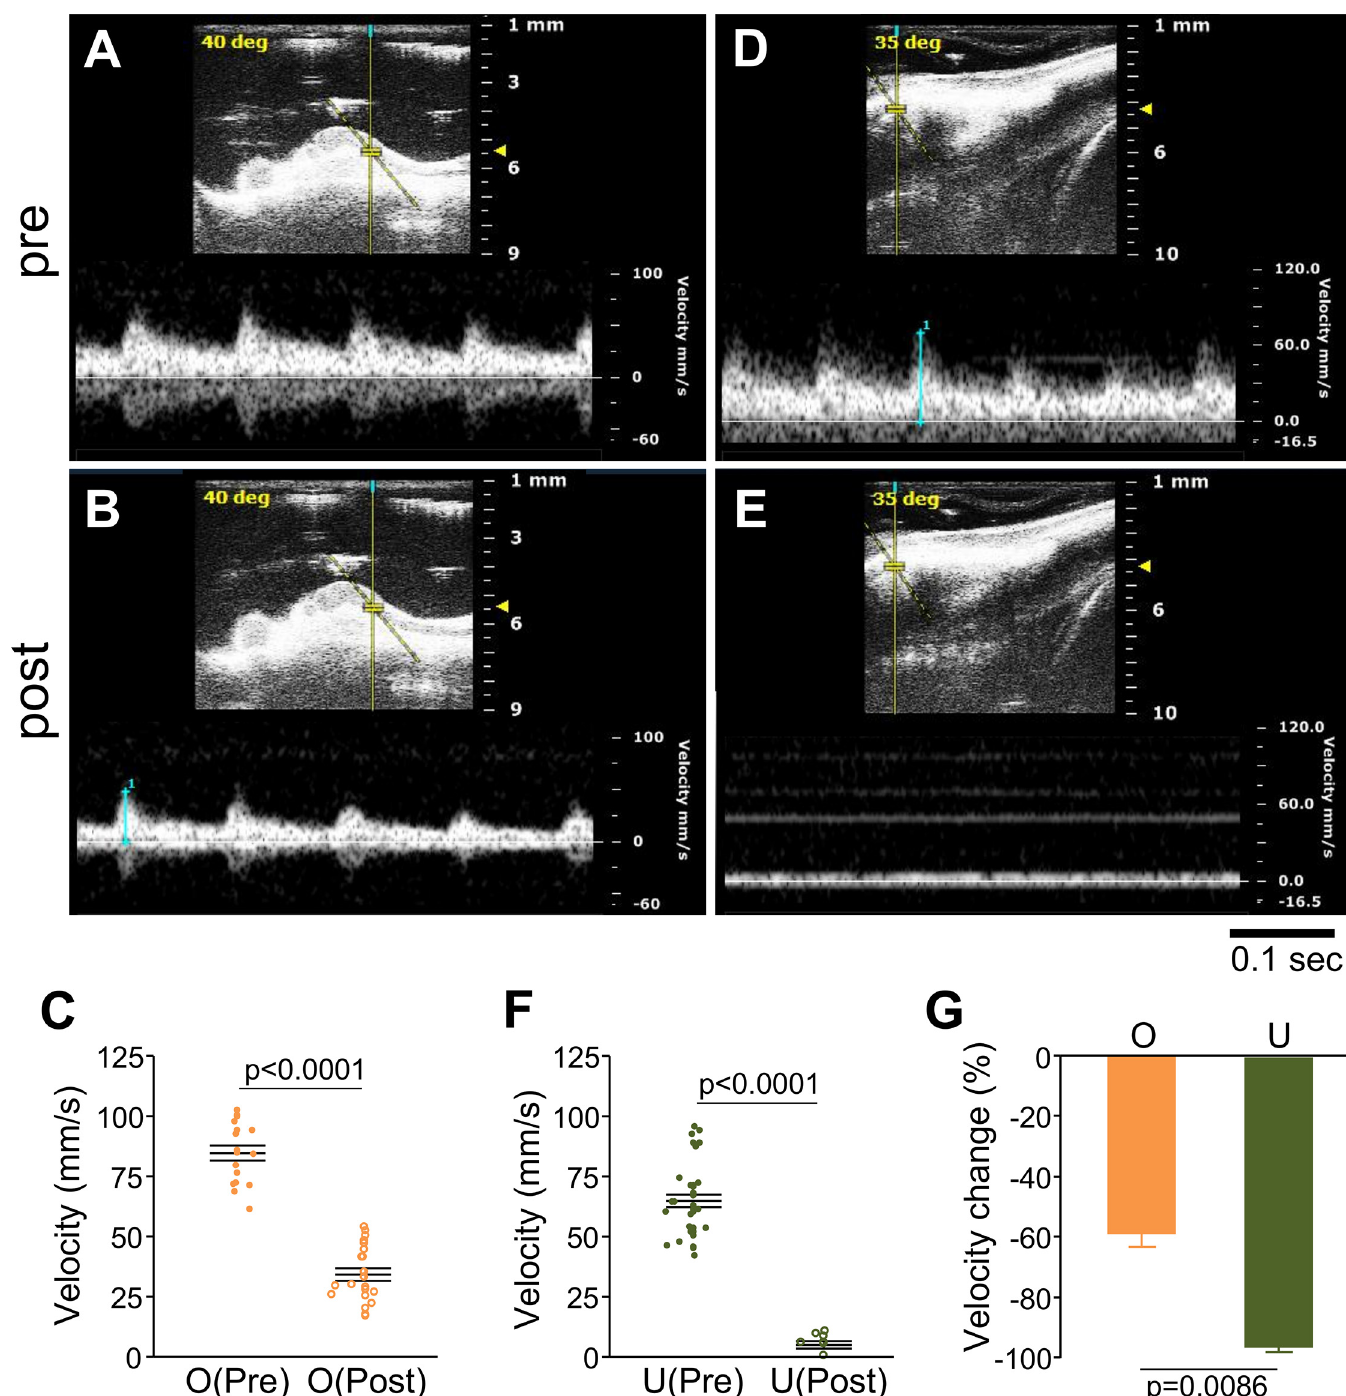
Fig 2. Ligation of uterine vessels reduces arterial blood flow of uterine arcades. Doppler blood velocity waveforms were obtained from an artery of the uterine arcade before ( A ) or after ( B ) ligation of ovarian vessels. ( C ) Summary of arterial blood flow velocity of 4 uterine arcades (4 peaks each) before and after ligation of ovarian vessels. Doppler blood velocity waveforms were obtained from an artery of the uterine arcade before ( D ) or after ( E ) ligation of uterine vessels. ( F ) Summary of arterial blood flow velocity of 5 uterine arcades (4 peaks each) before and after ligation of uterine vessels. ( G ) Percentage of velocity change relative to velocity before ligation. n = 4 (ovarian vessels) and n = 5 (uterine vessels).